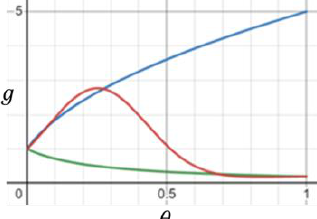
√ 24 θ + 1 (blue), and